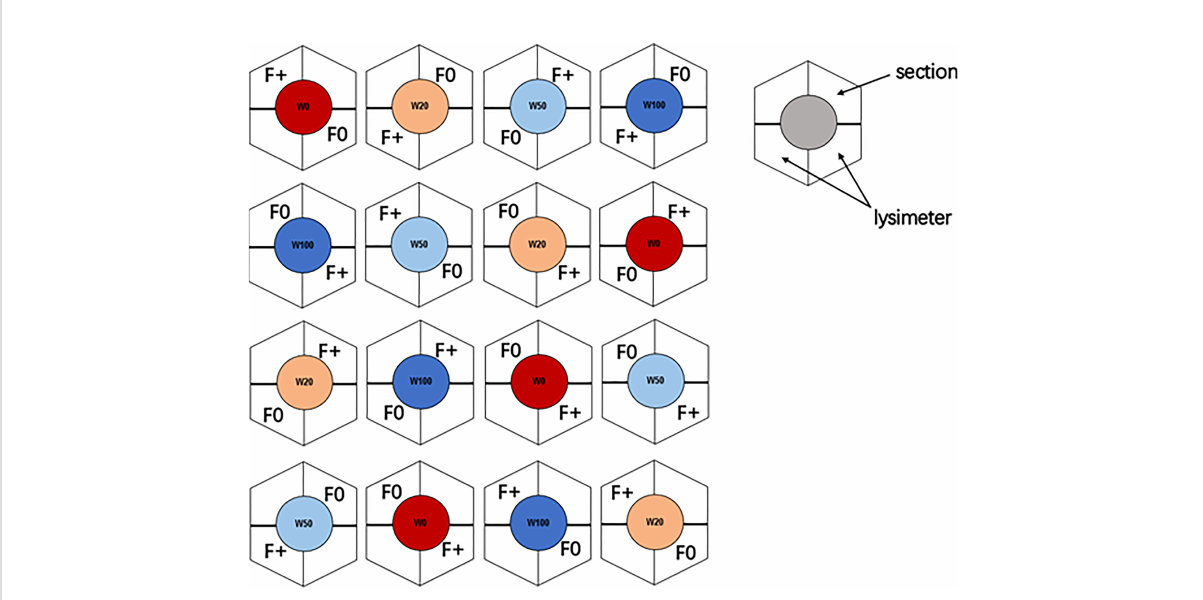
FIGURE 1 Experimental setup of the 16 open top chambers. Colors indicate the four different drought regimes: dark blue = W100 (close to fi eld capacity), light blue = W50 (50% of fi eld capacity), brown = W20 (20% of fi eld capacity), and red = W0 (close to wilting point). Nutrient regime is represented with F0 (unfertilized) and F+ (fertilized)